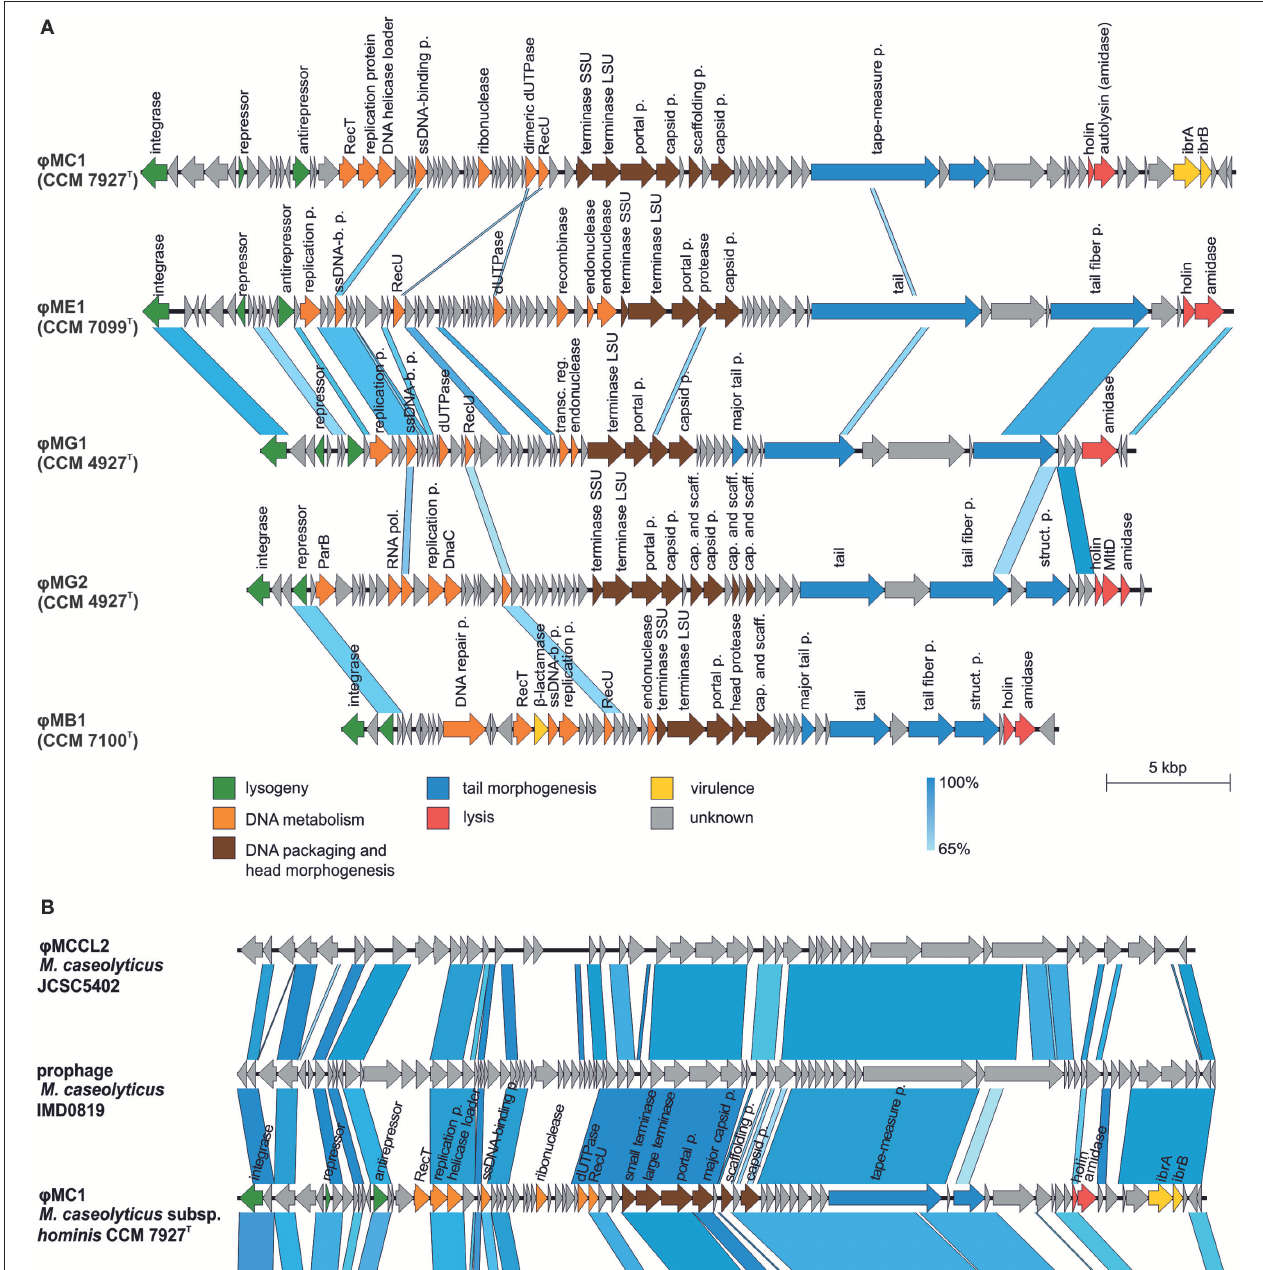
Frontiers in Microbiology | www.frontiersin.org